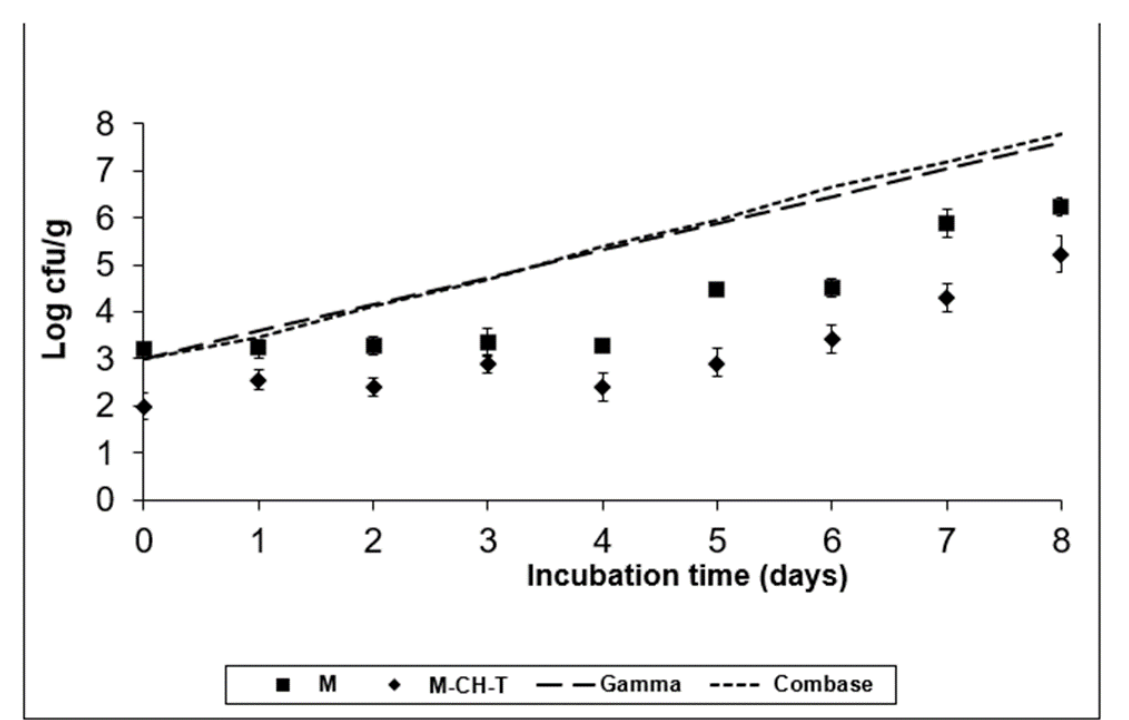
Figure 2. Growth of L. monocytogenes on the RTC product stored at 8 °C, under MAP (M; ■ ), under MAP with Chitosan/Thyme oil (M-CH-T; ♦ ) using the Gamma prediction model ( —— ) and the Com-base ® model (- - - -). M denotes RTC product, stored under MAP and M-CH-T a product stored under MAP, treated with Chitosan and Thyme.